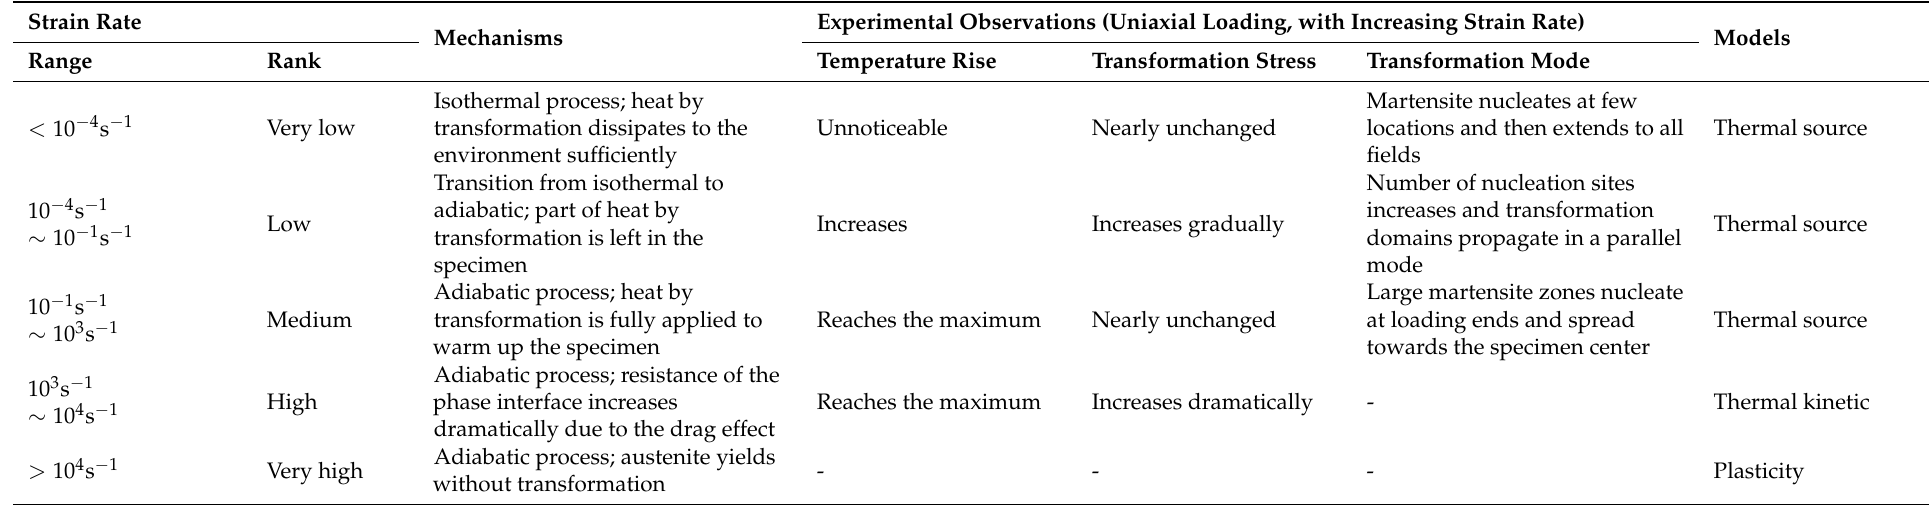
Table 1. A summary of mechanisms, experimental observations, and models at different strain